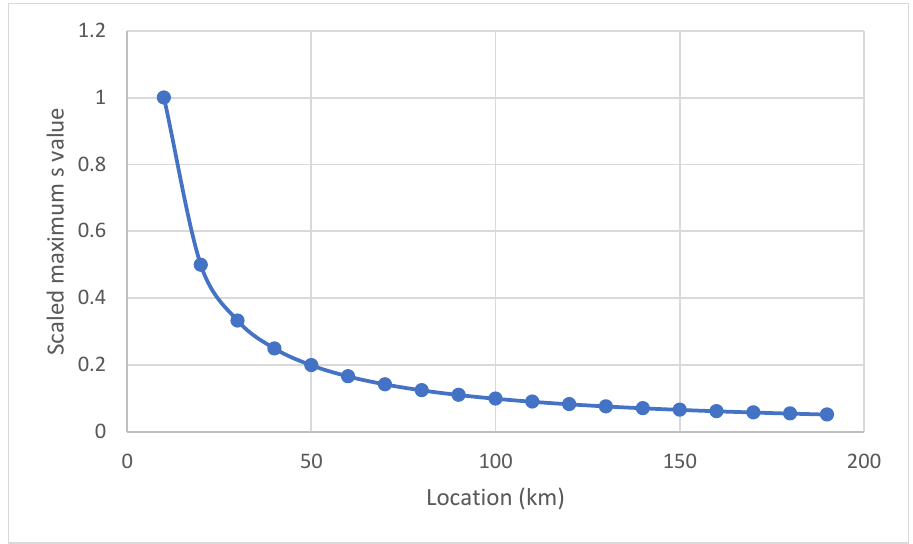
Figure 9. The best fitting curve at 19 fault locations for LLL fault using scaled maximum singular value. Table 6. LG fault prediction error utilizing line current